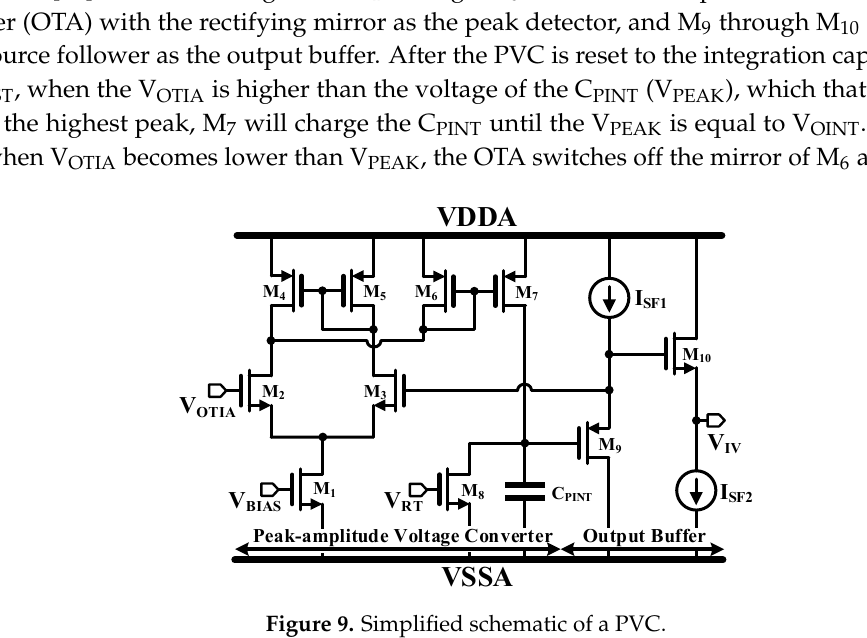
Figure 8. ( a ) Simplified schematic of a TVC and ( b ) its operation.